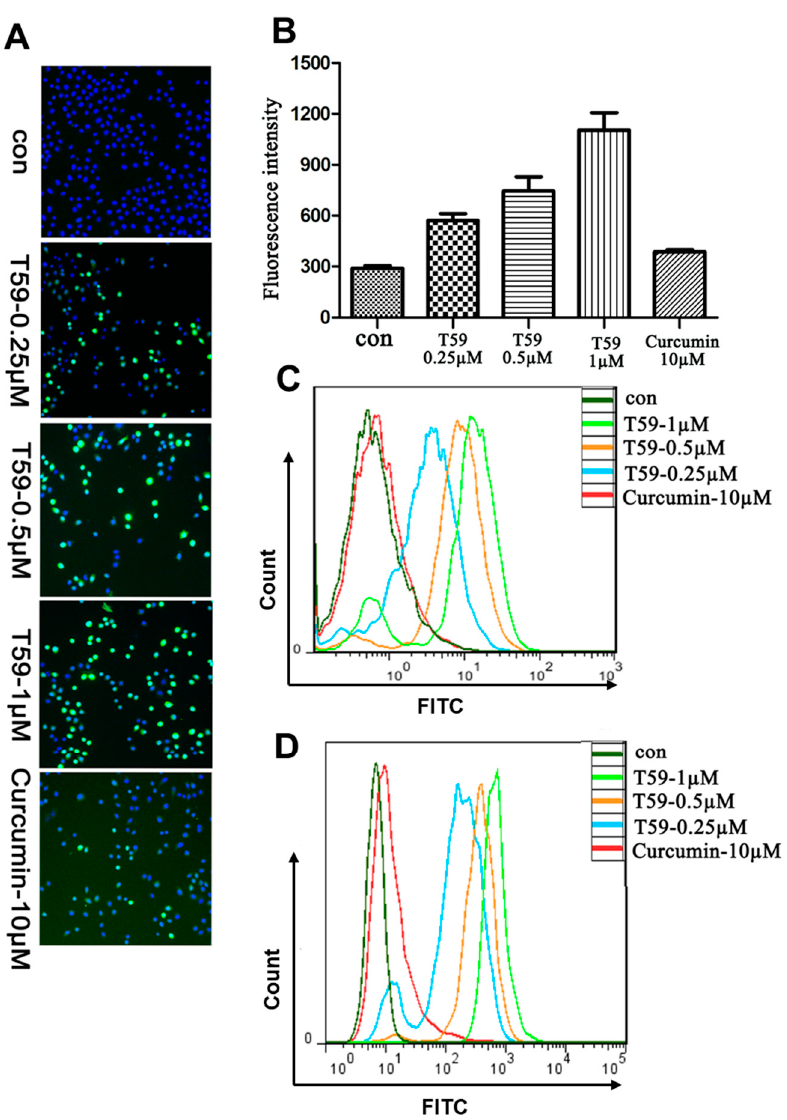
Figure 4. T59 induced elevated levels of ROS. ( A ) Representative images of A549 cells treated with medium including 0.250 µ M, 0.500 µ M, and 1.000 µ M T59 and with 10.000 µ M curcumin for 6 h and stained with DCFH-DA. ( B ) The fluorescence intensity in ( A ) was shown as the histogram. Data are shown as mean ± SD. ( C ) After treatment for 24 h, A549 cells were stained with DCFH-DA and analyzed by flow cytometry. ( D ) After being treated for 24 h, H1975 cells were stained with DCFH-DA and analyzed by flow cytometry.